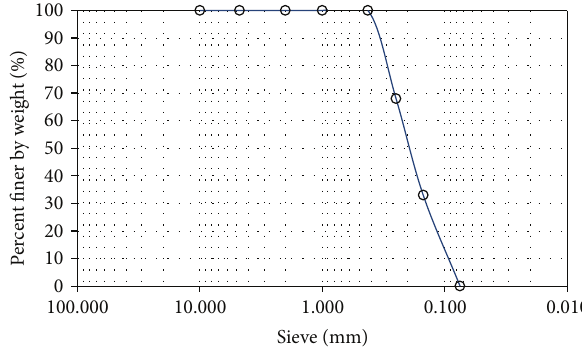
Figure 1: Particle size of the sample test